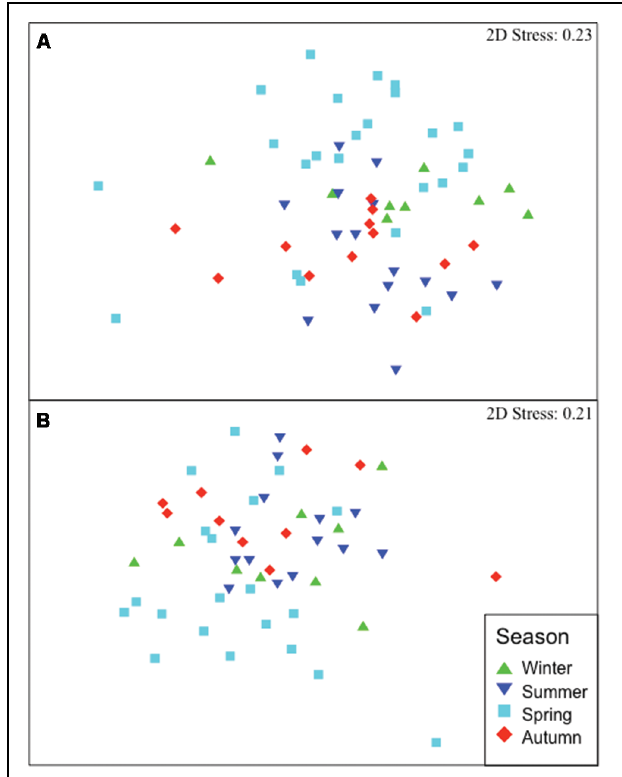
FIGURE 1 | Non-metric multi-dimensional scaling (nMDS) plots of bacterial community similarity in Didemnum fulgens over the 16 months of study and for each season. nMDS ordination based on Bray-Curtis similarity of T-RFLP profiles for HaeIII (A) and MspI (B) datasets. Stress values (goodness-of-fit between two-dimensional ordination distances and similarity matrix distances) are shown in parenthesis for each enzyme (range = 0 to 1, lower values = better